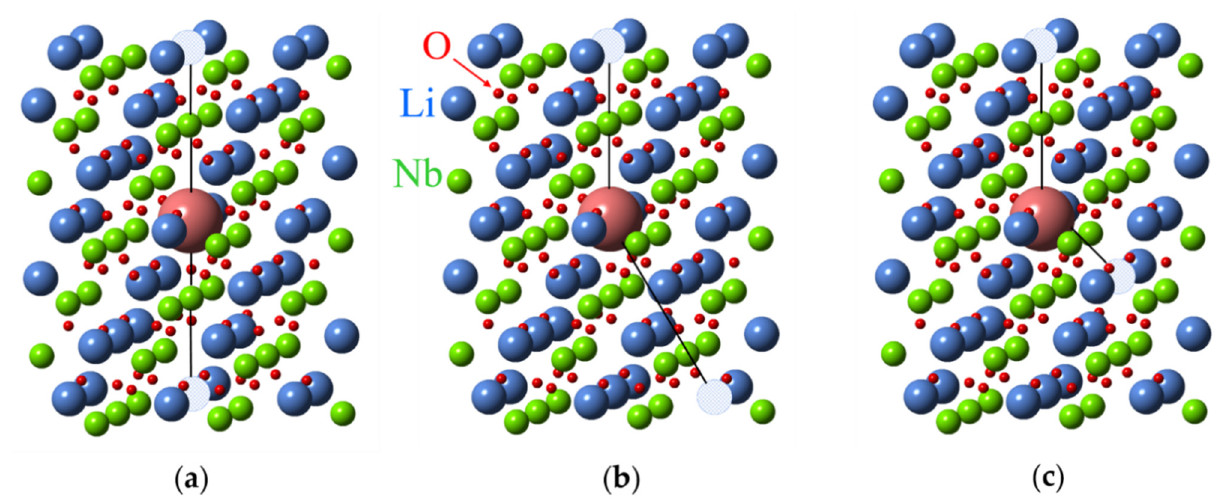
Figure 8. Divacancy models for an impurity substituted for Li + ion in LN crystal lattice. Hatched circles represent two v Li . ( a ) Axial center, ( b ) nearly axial center, ( c ) low-symmetry center.